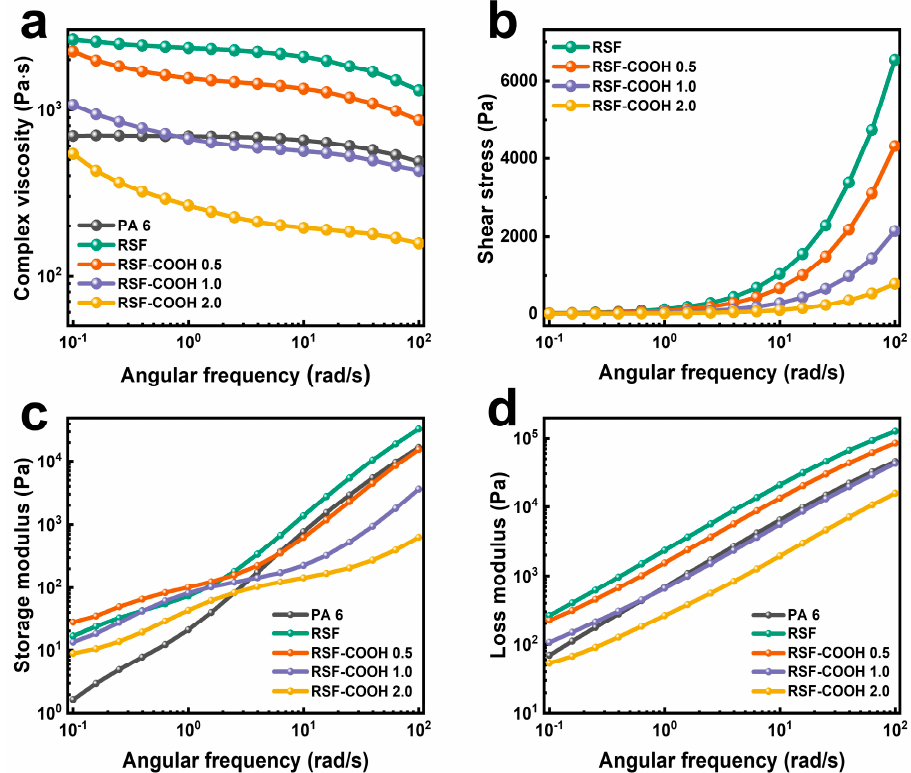
Figure 2. Complex viscosity ( a ), shear stress ( b ), storage modulus ( c ), and loss modulus ( d ) of the neat PA6 and RSF composites with different HBP contents.